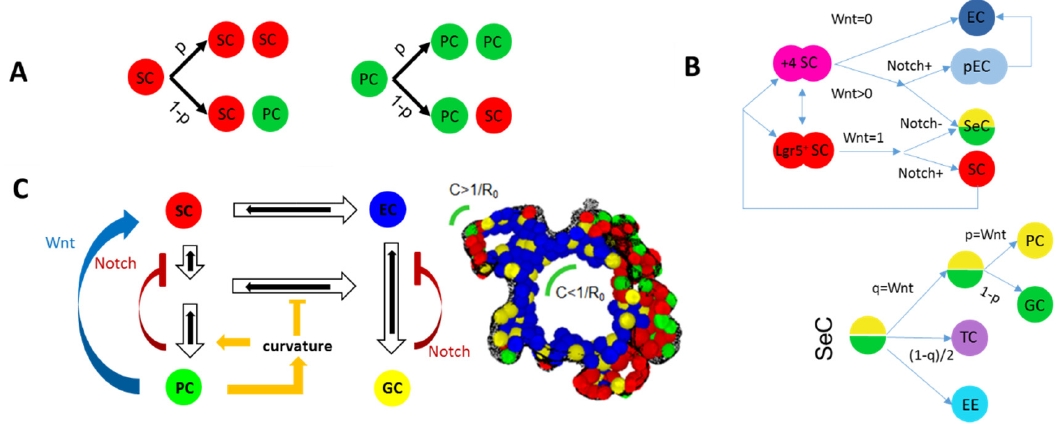
Figure 2. SC specification and differentiation in intestinal COMs. ( A ) Intrinsic regulation as suggested by Almet et al. [22]. Two types of cells (SC: stem cell (soft), PC: Paneth cell (hard)) divide asymmetric or symmetric with a defined probability p Є [0,1]. ( B , C ) Environmentally regulated fate: ( B ) Detailed scheme provided by Pin et al. [16,21]. Dividing SCs self-maintain or irreversibly specify into absorptive or secretory cells/progenitors depending on externally provided Wnt and Notch signaling. Further specification into different secretory cells is controlled by the probabilities p and q that are Wnt-dependent. SeC: secretory cell, GC: goblet cell, TC: tuft cell, EE: enteroendocrine cell, pEC: enterocyte progenitor, EC: enterocyte. ( C ) Tissue shape-dependent regulation [20]. Fully reversible lineage specification is linked to Wnt and Notch signaling. PC specification in addition requires a threshold tissue curvature: C > 1/R 0 . R 0 : local curvature radius of the